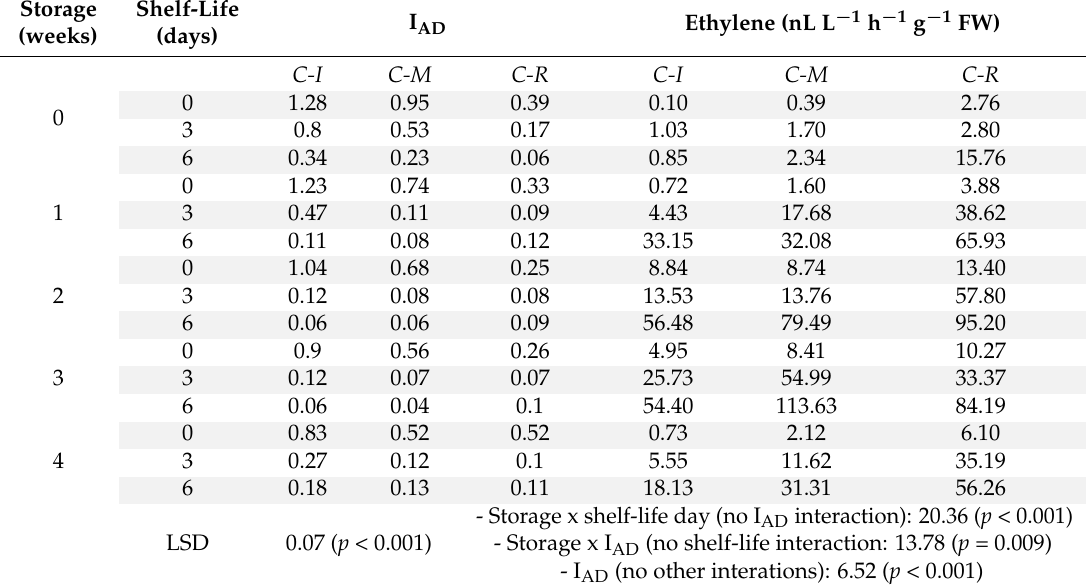
Table 1. Non-destructive determination of fruit ripening evolution based on absorption difference index (IAD) and ethylene emission. ‘August Flame’ peaches were assessed at harvest (week 0) and after storage (0 ◦ C) for up to 4 weeks and shelf-life (ambient, 18 ◦ C) for up to 6 days for C-I (immature), C-M (mature) and C-R (ripen) fruit. LSD indicates significant